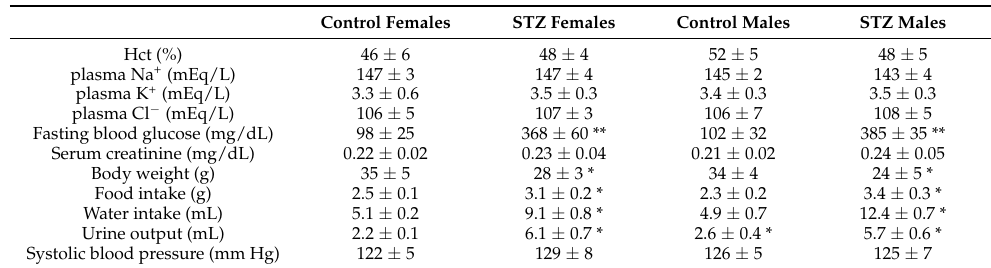
Table 1. Physiological parameters in male and female mice after 6 days of a single dose of streptozo- tocin. * p < 0.05, ** p <